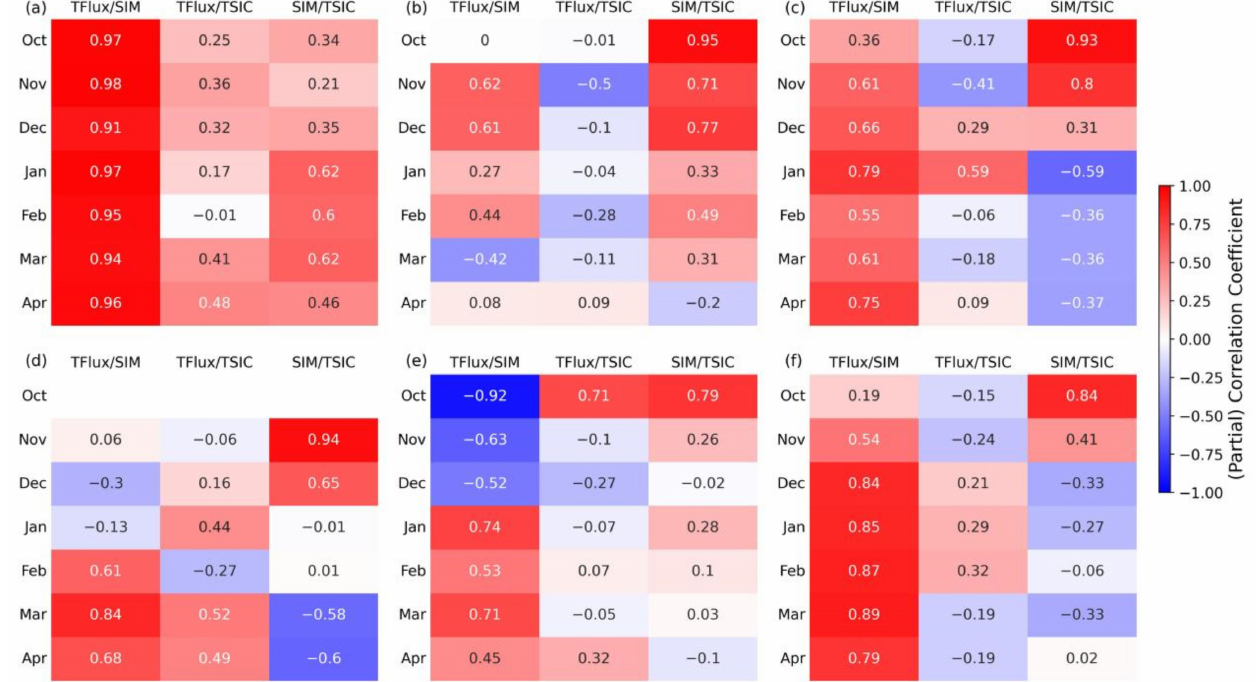
Figure 6. Partial CCs of total sea ice areal flux (TFlux) with sea ice motion (SIM) and total sea ice concentration (TSIC) as well as the CC between SIM and TSIC in ( a ) Fram Strait, ( b ) S–FJ, ( c ) FJ–SZ, ( d ) Bering Strait, ( e ) Lancaster Sound and ( f ) North